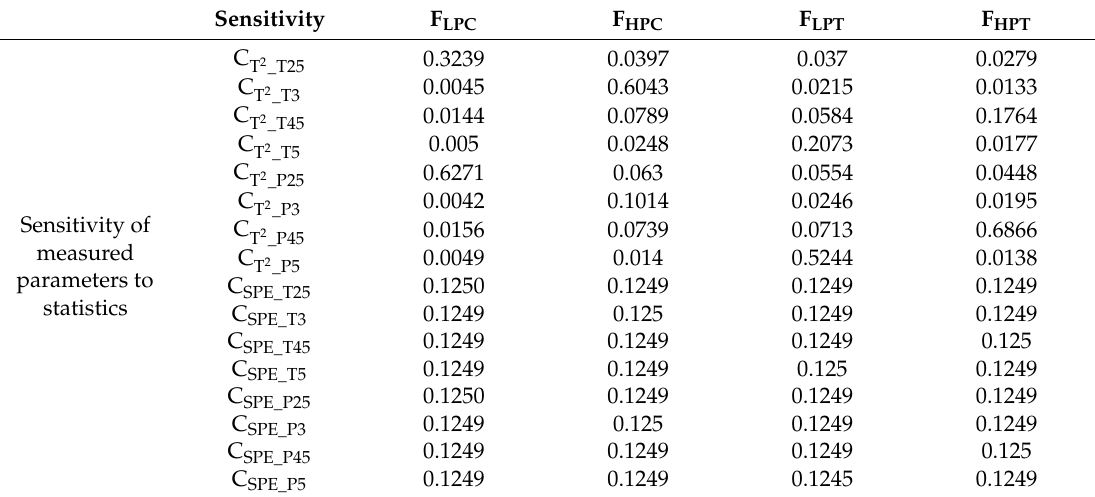
Figure 7. Value of the SPE (Squared Prediction Error) statistic under the condition of an LPT fault. Table 2. The sensitivity of measured